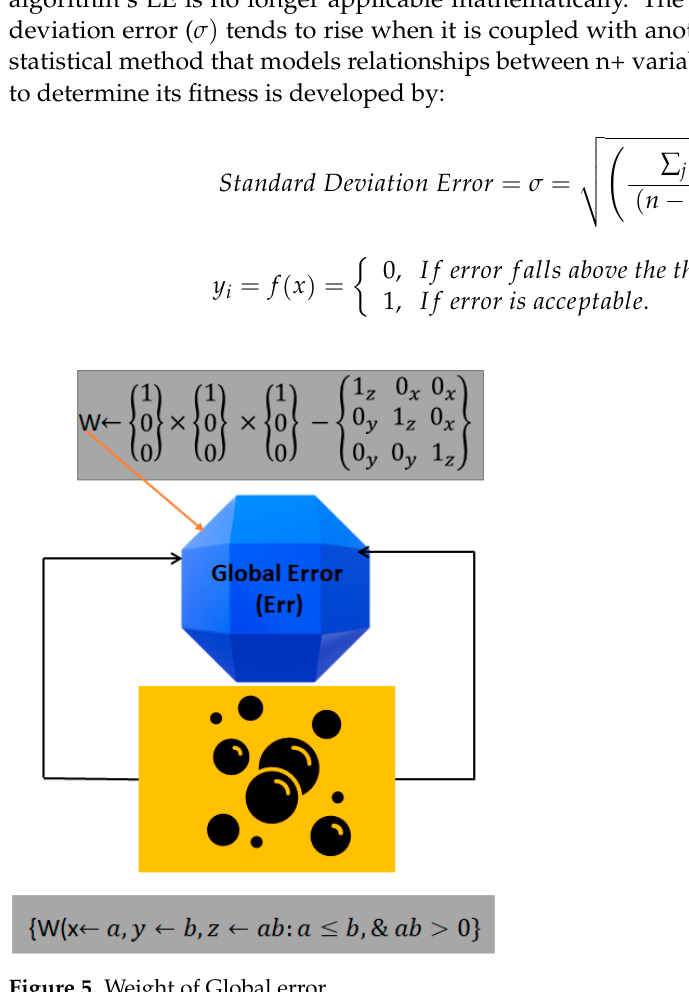
Figure 5. Weight of Global error.